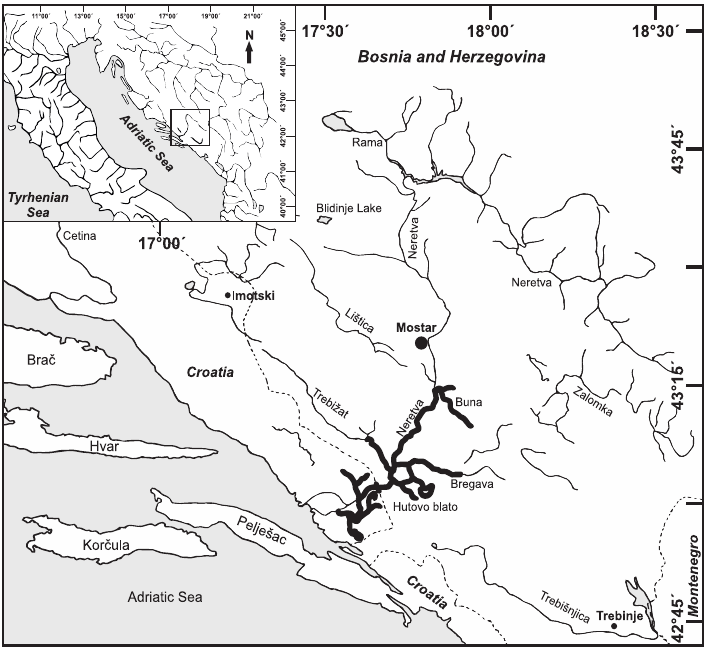
Fig. 2. Distribution map of the Neretva nase, Chondrostoma knerii (thick black lines) in the Adriatic Sea